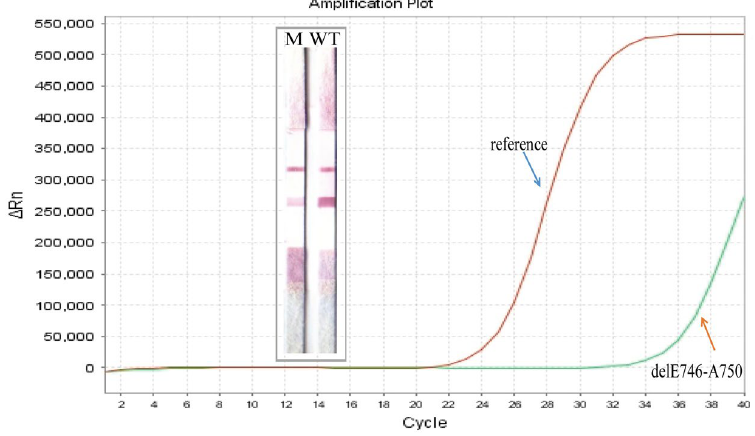
Figure 4. Validation the delE746-A750 result by qPCR method for No. 1